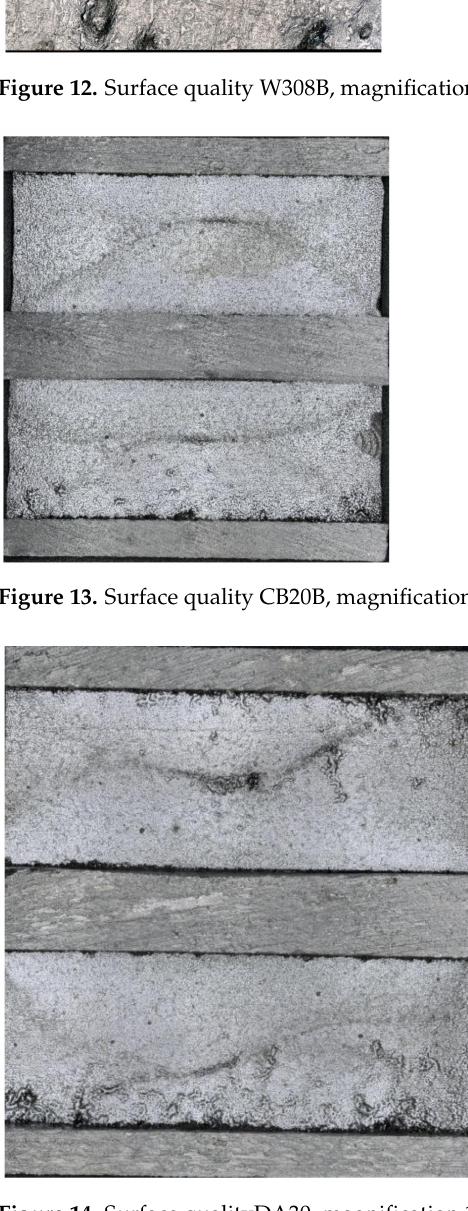
Figure 14. Surface qualityDA30, magnification 10 ×